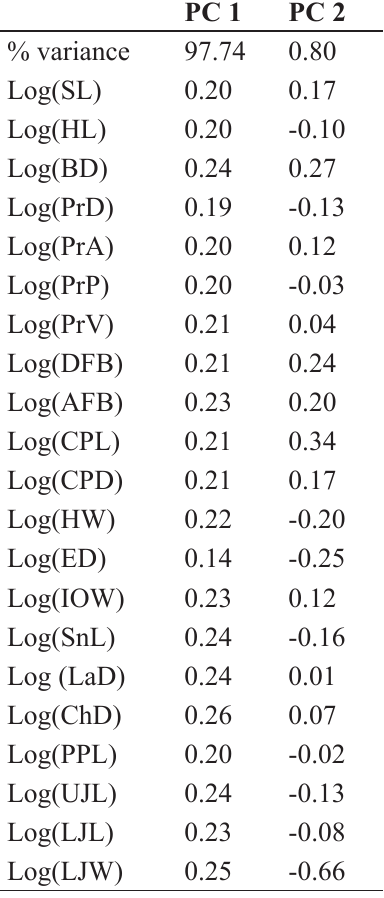
Table S4. PCA loadings of 21 log-transformed measurements from: H . aquila sp. nov., H . falcatus sp. nov., H . curvidens sp. nov., and H . squamipinnis . Results illustrated in Fig. 3d. Abbreviations: SL = standard length; HL = head length; BD = body depth; PrD = predorsal distance; PrA = preanal distance; PrP = prepectoral distance; PrV = prepelvic distance; DFB = dorsal fin base length; AFB = anal fin base length; CPL = caudal peduncle length; CPD = caudal peduncle depth; HW = head width; ED = eye diameter; IOW = interorbital width; SnL = snout length; LaD = lachrymal depth; ChD = cheek depth; PPL = premaxillary pedicel length; UJL = upper jaw length; LJL = lower jaw length; LJW = lower